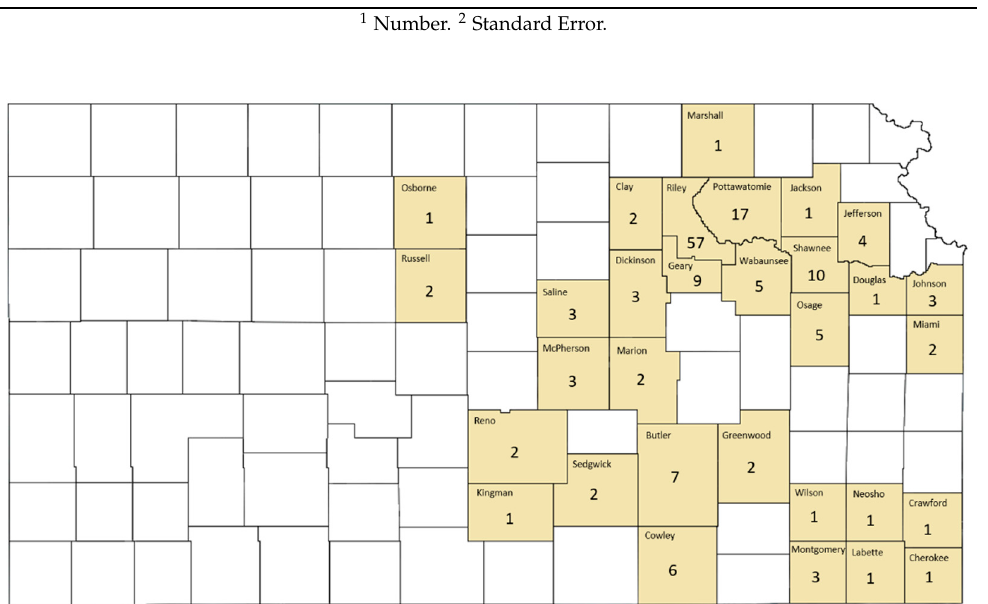
Figure 3. County-level location of acute cytauxzoonosis diagnosed domestic cat records in Kansas. Acute cytauxzoonosis case samples were submitted from cat(s) in shaded Kansas counties while no cat records were identified from unshaded counties. Numbers represent raw acute cytauxzoonosis case